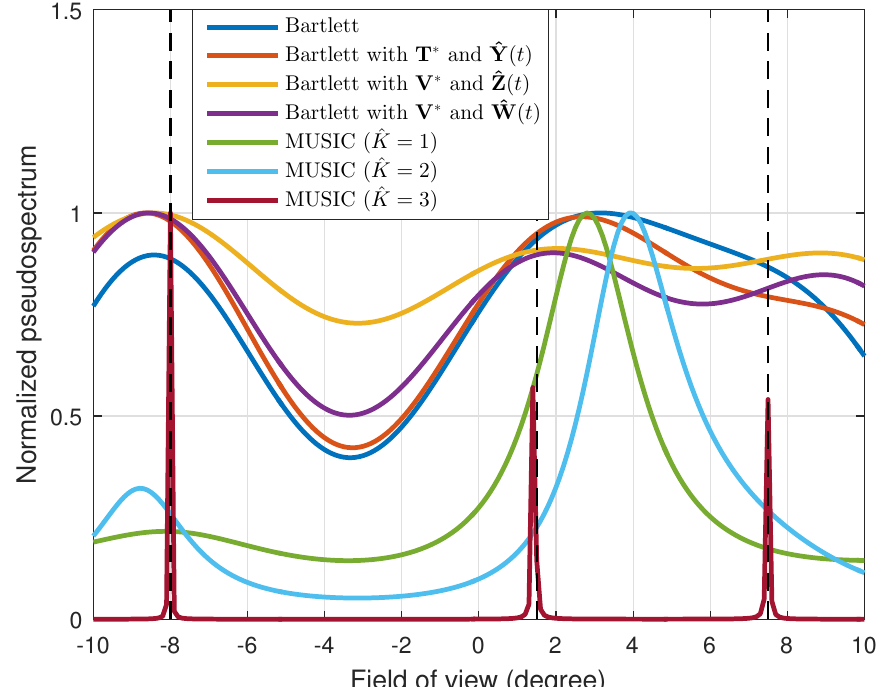
Figure 7. Normalized pseudospectrums for three targets located at [ − 8 ◦ , 1.5 ◦ , 7.5 ◦ ]